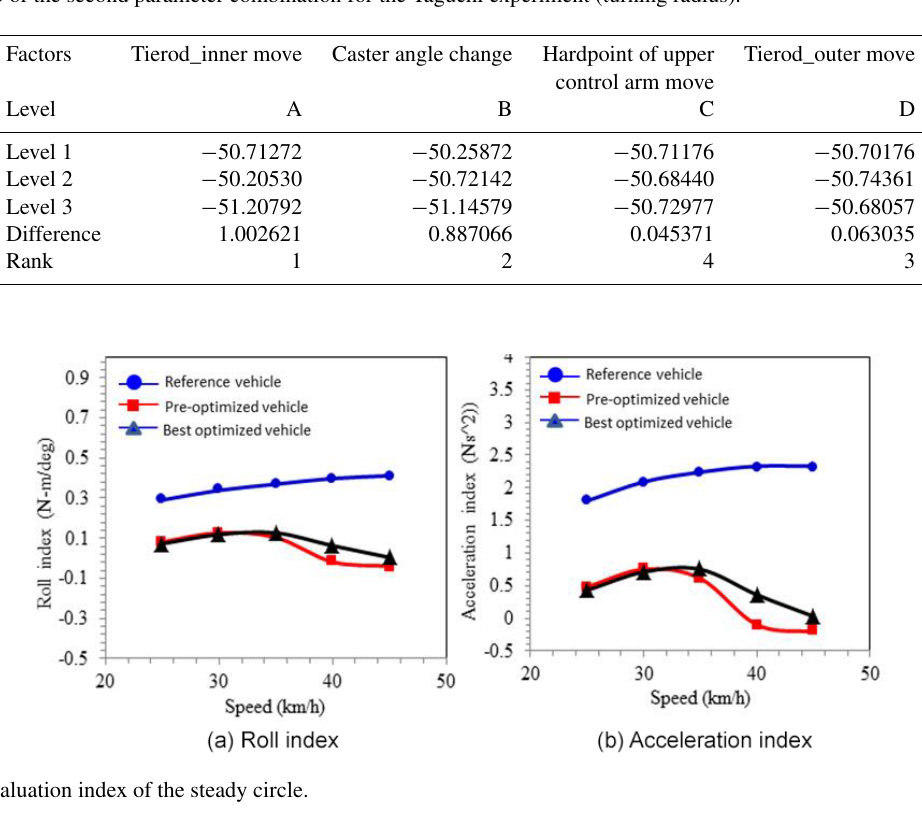
Table 14. SN ratio of the second parameter combination for the Taguchi experiment (turning radius).